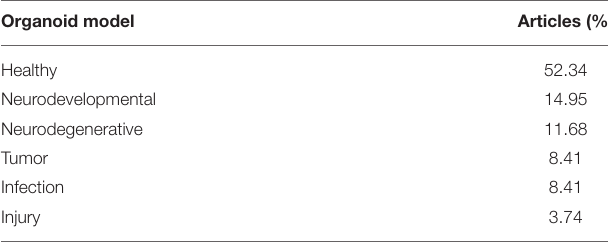
TABLE 1 | Percentage of articles studying diseases on cerebral organoids over 2019 and 2020. Organoid